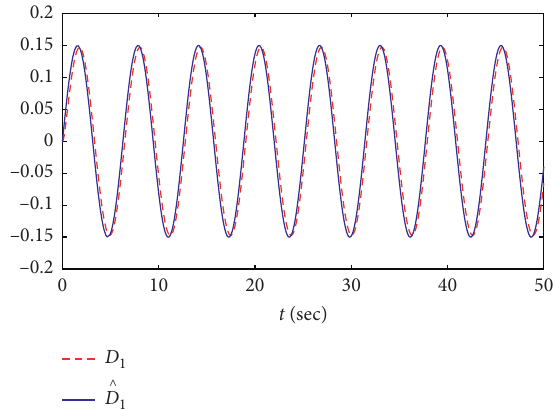
Figure 6: The estimation result of the sensor fault D